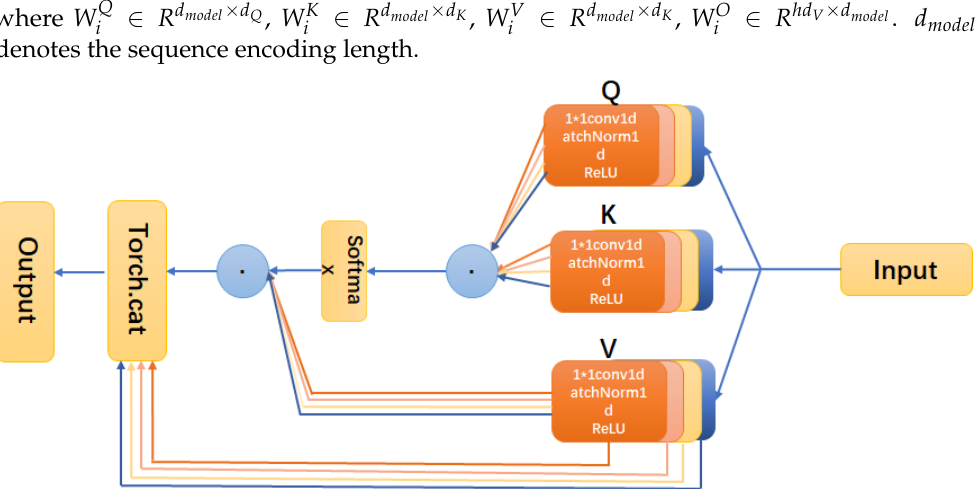
Figure 4. Coordinated attention module.